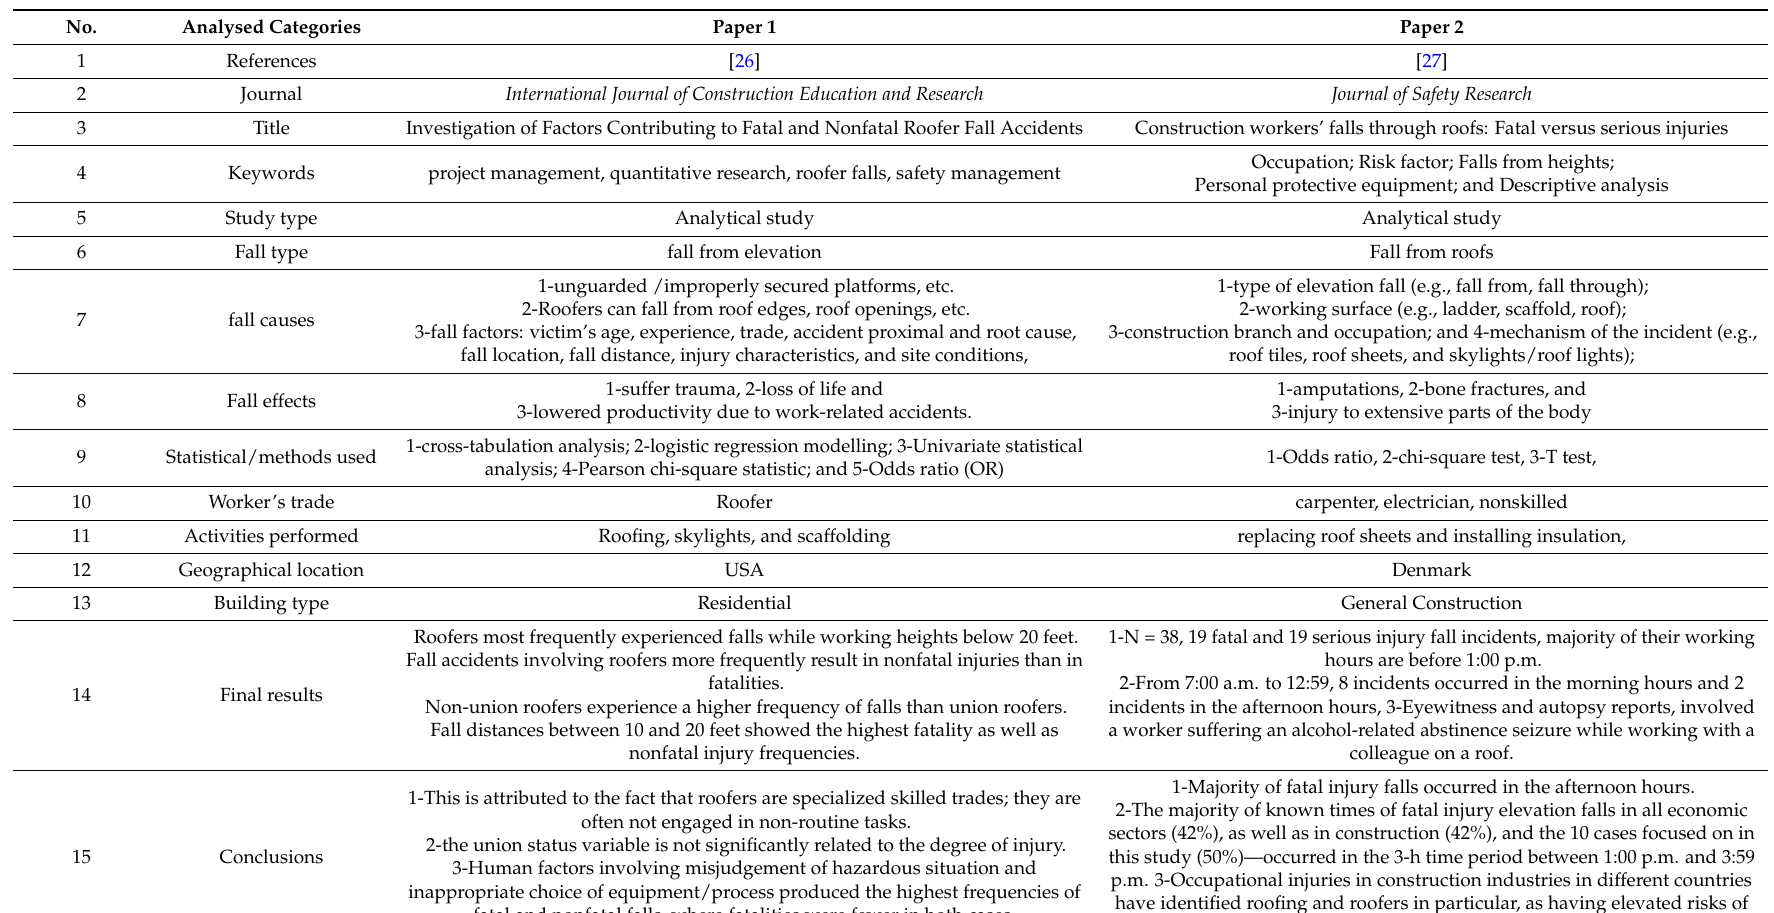
Table A1. An example of 2 records in the coded